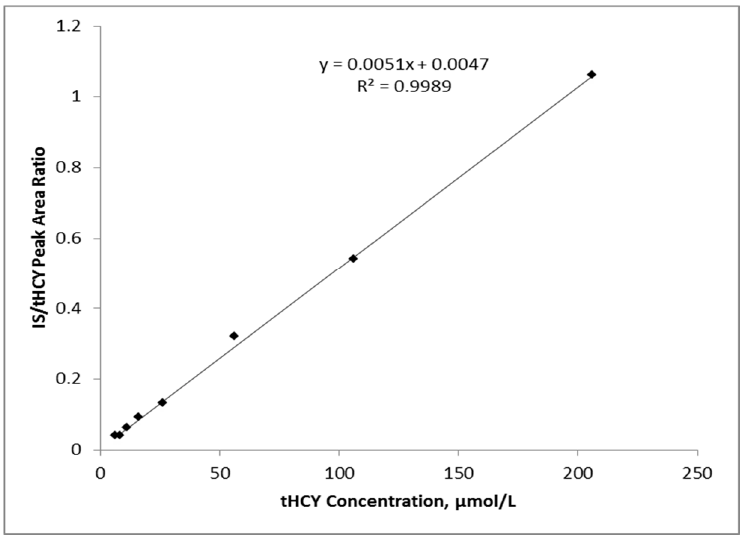
Figure 2. Calibration of internal standard/tHCY peak area ratio with tHCY standards. A linear response was obtained with tHCY concentrations from 6 to 206 µmol/L.